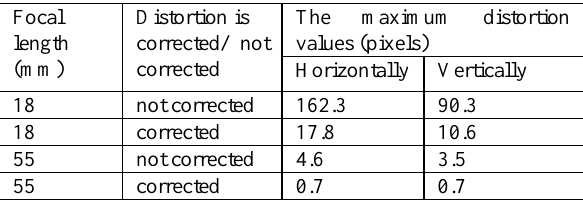
Table 2. The maximum values of radial distortion in the